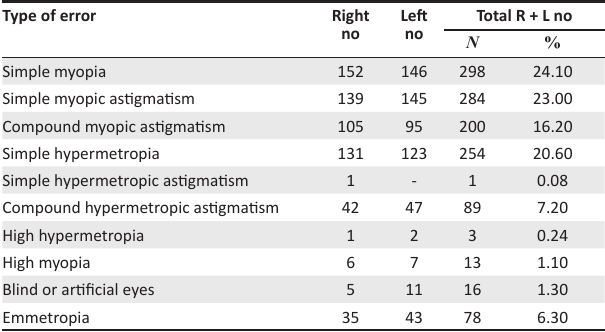
TABLE 2: Types of refractive errors. Type of